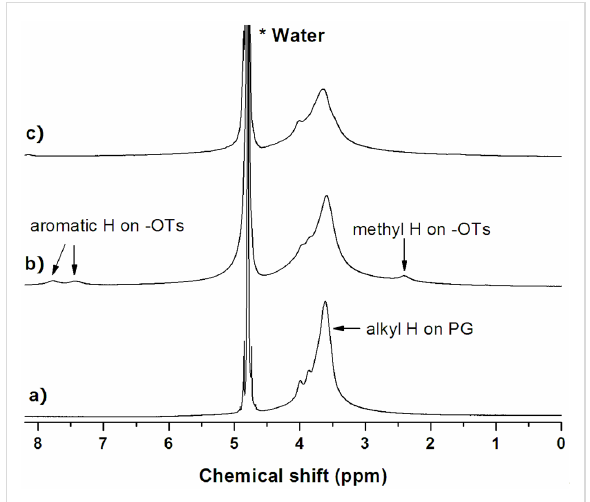
Figure 2: 1 H NMR spectra of a) ND50-PG, b) ND-PG-OTs and c) ND-PG-N 3 in D 2 O.